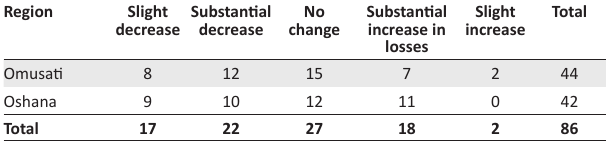
TABLE 7: Changes in disaster loss per